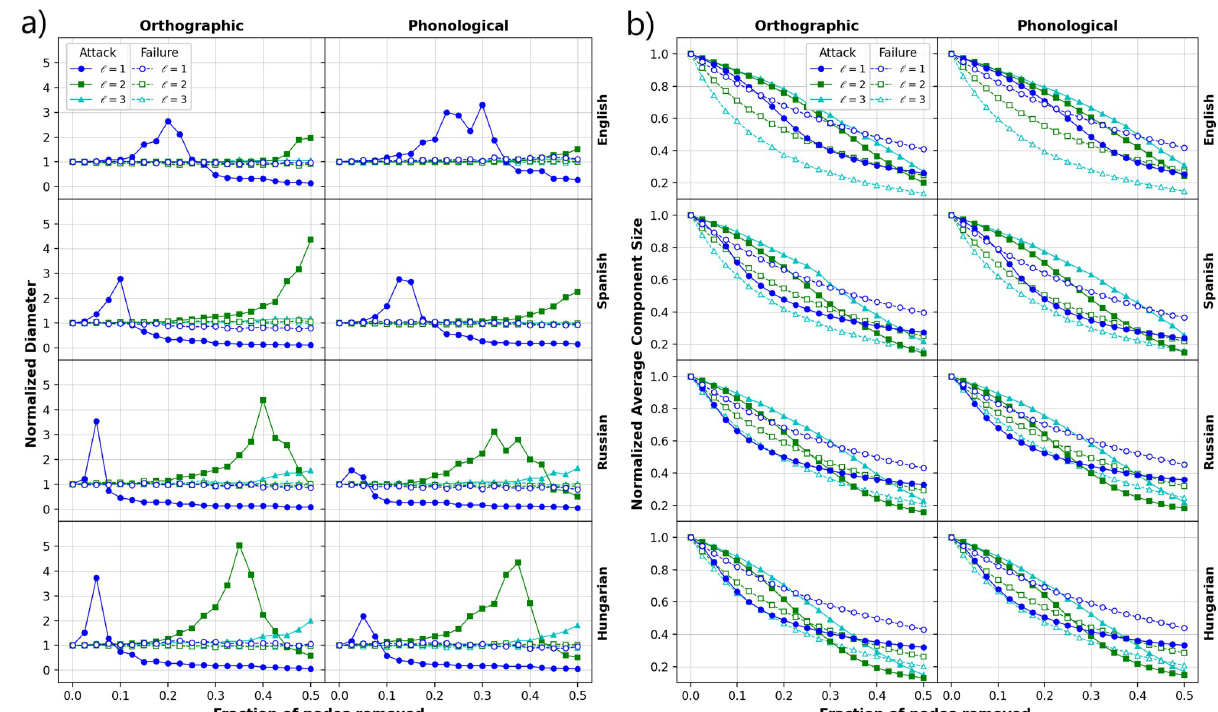
Fig 7. Robustness of the networks. Directed attacks consist in removing the most connected nodes and for the failures nodes are removed randomly. a) Behavior of the normalized diameter in terms of the fraction of removed nodes. b) As above but for normalized component size. Different profiles for the decay are observed when comparing orthographic and phonological networks from the four languages. The results for failures correspond to the average from 10 independent realizations.